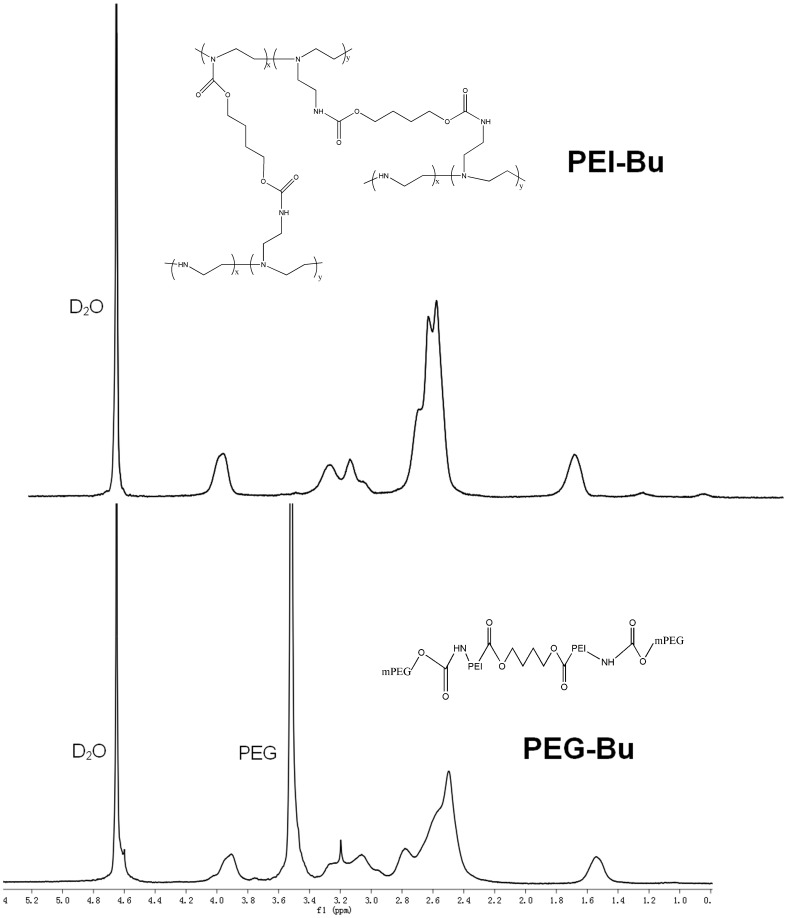
Representative 1H-NMR spectra of PEG-Bu.